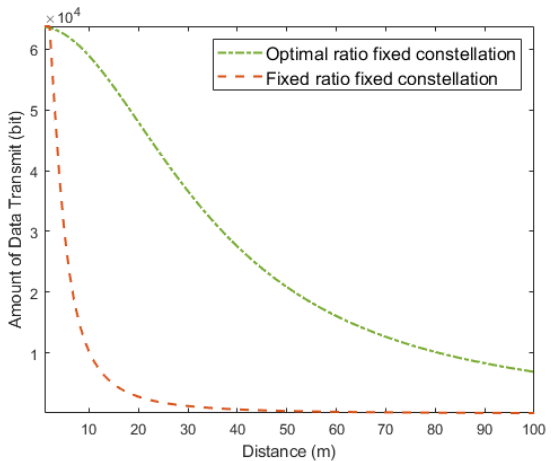
Figure 4. Fixed constellation versus optimized constellation size at a fixed time ratio.